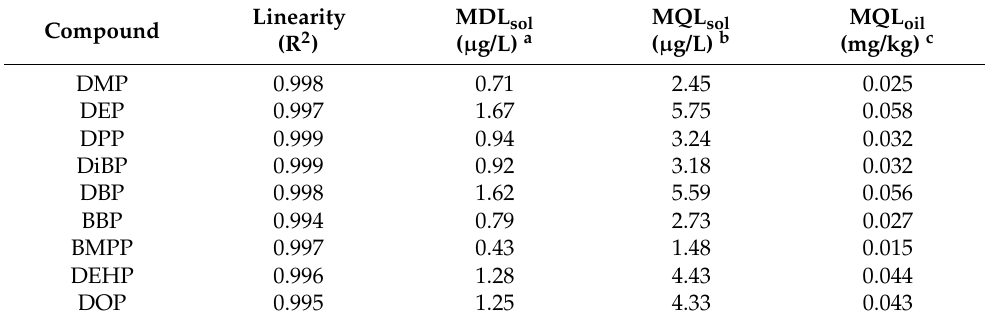
Table 2. Linearity, method detection limit, and method quantitation limit in the solution and vegetable